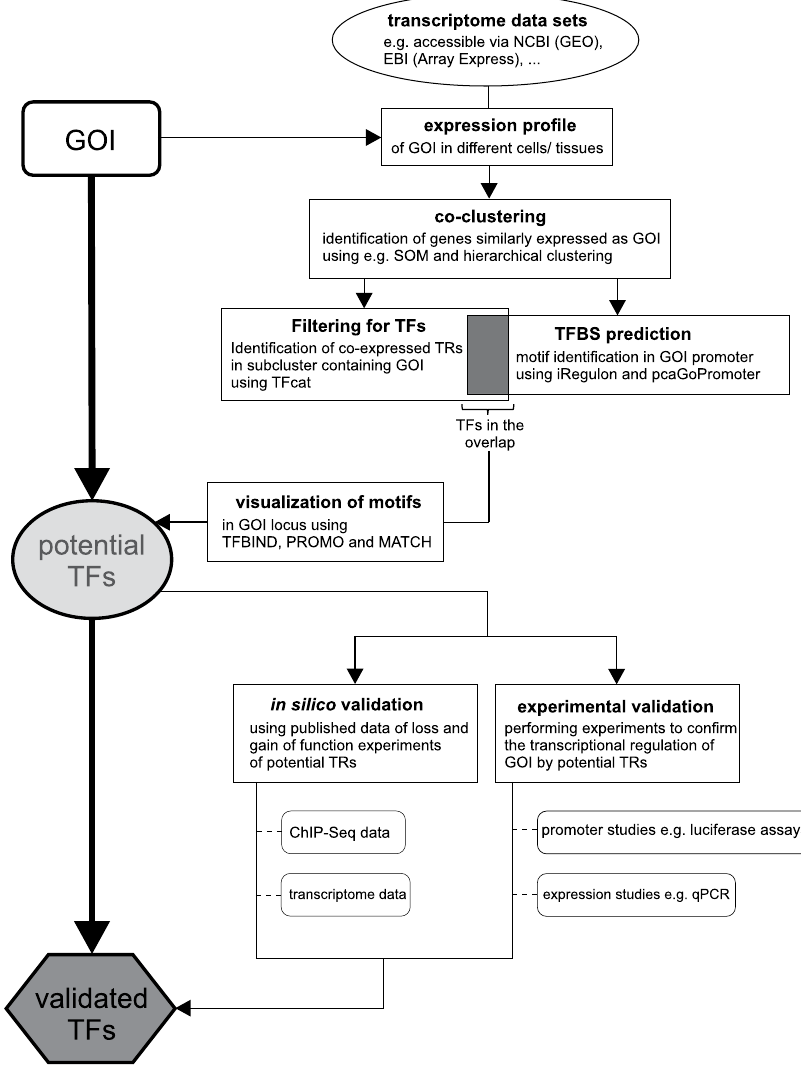
Figure 6. Schematic workflow. (GOI = gene of interest, SOM = self-organizing map, TFBS = transcription factor binding site, TR = transcriptional